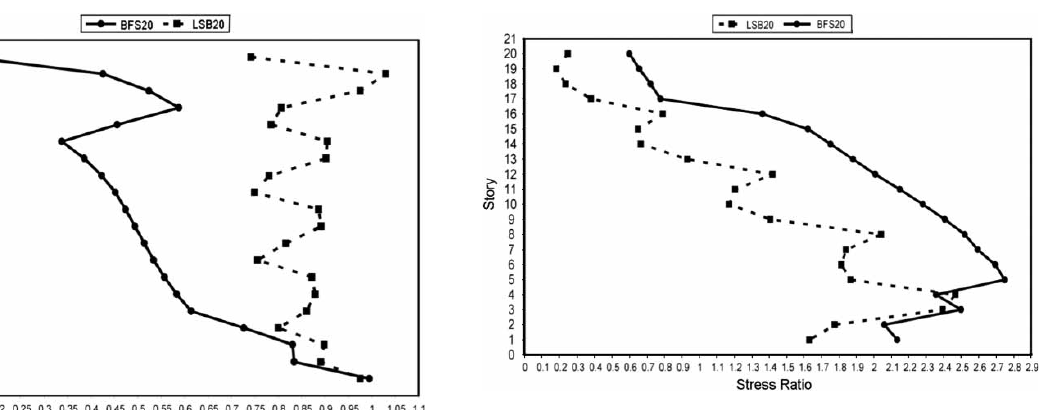
Fig. 21. Summation of the stress ratios in the columns of all models in each story